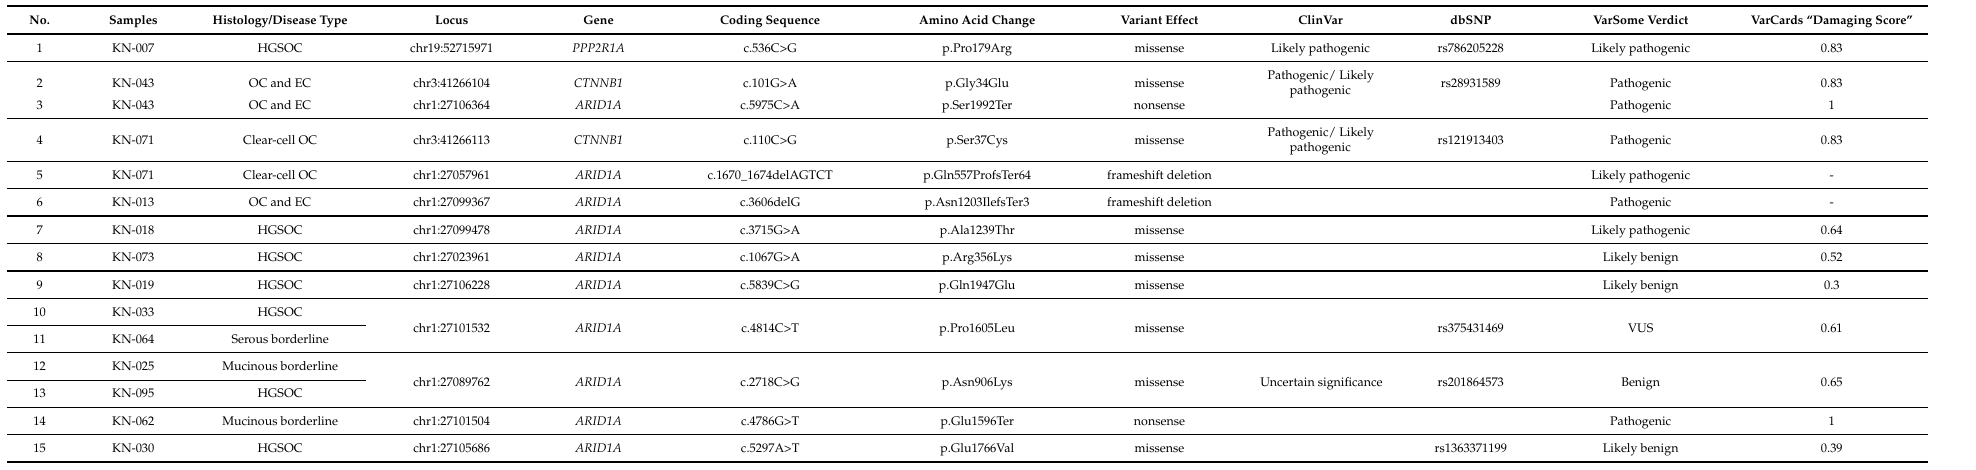
Table 1. Observed alterations and their predicted